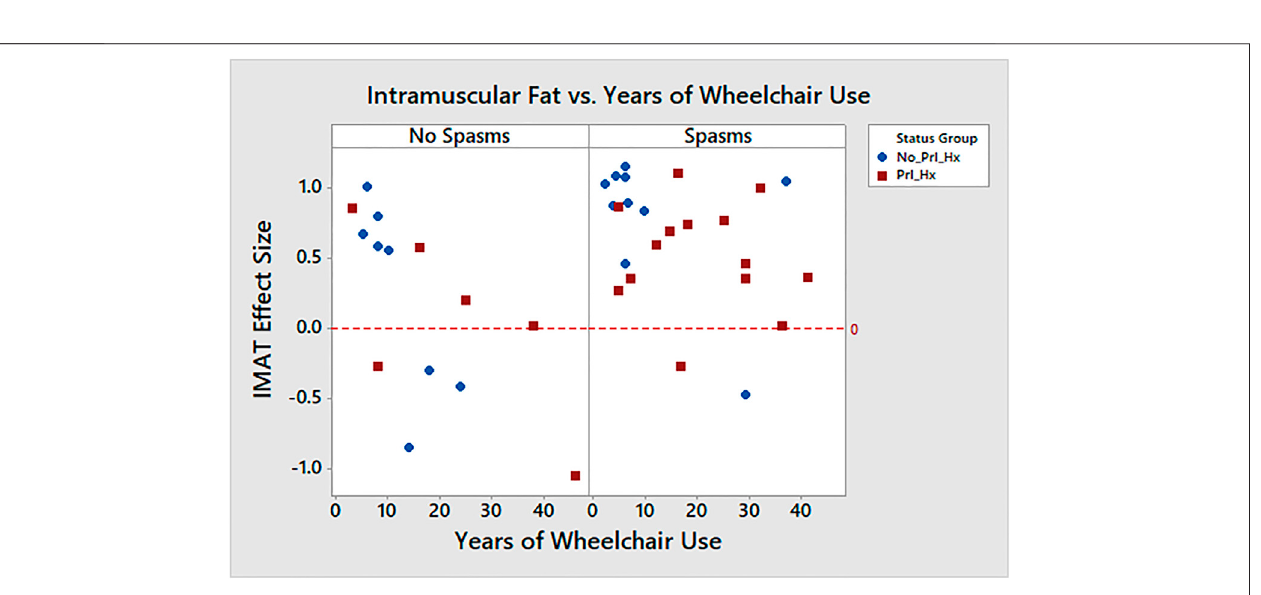
FIGURE 7 | Intramuscular fat vs. years of wheelchair use per